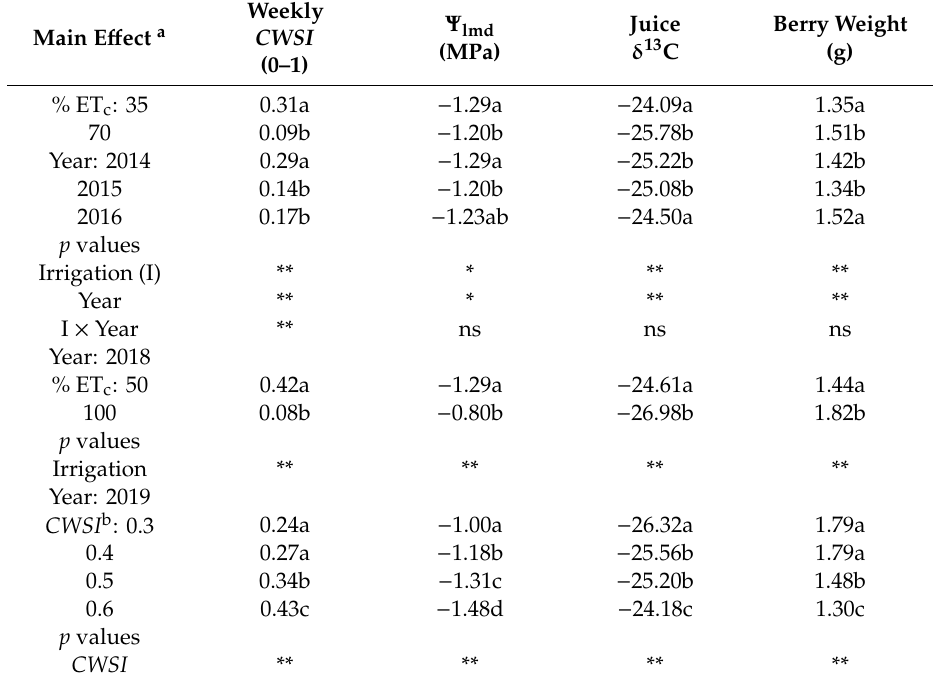
Table 2. Malbec grapevines grown in southern Idaho under semi-arid conditions and drip-irrigated weekly (2014, 2015, 2016, 2018) to supply di ff ering fractions of estimated water demand (ET c )